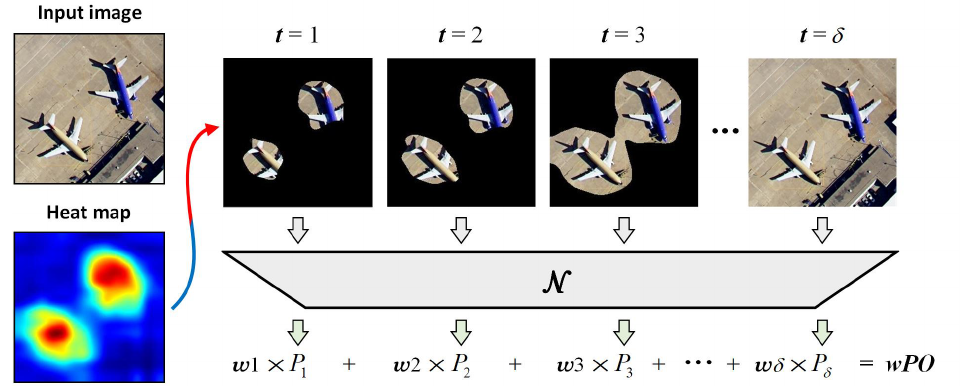
Figure 4. Illustration of the weighted probability of occlusion